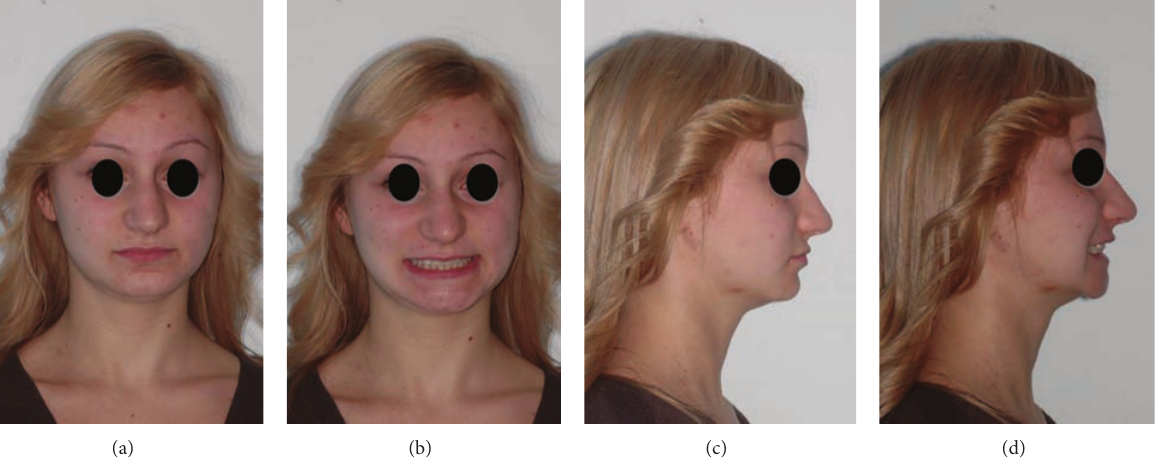
Figure 7: Extraoral photographs after treatment.